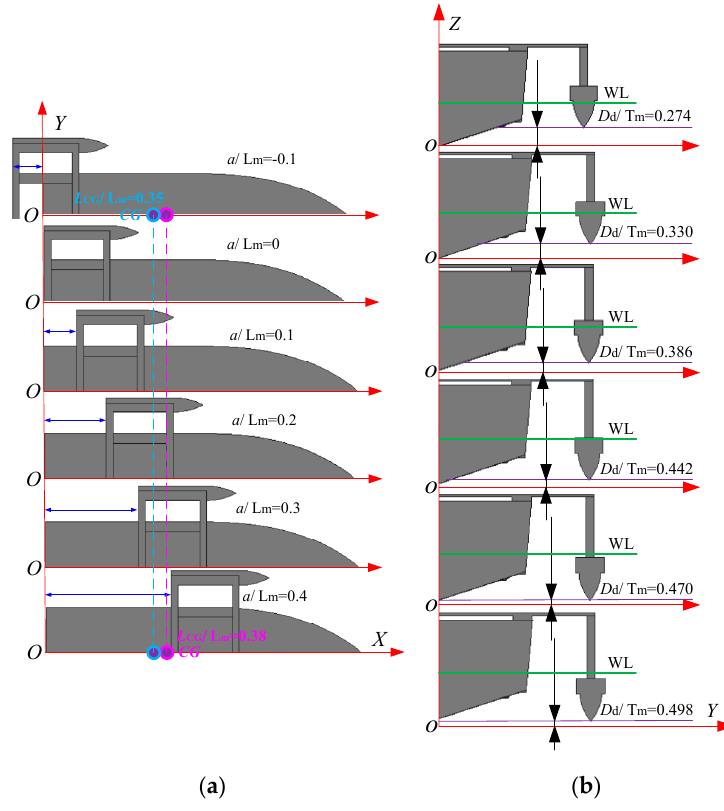
Figure 27. Longitudinal adjustment mode of the twin side ‐ hulls.